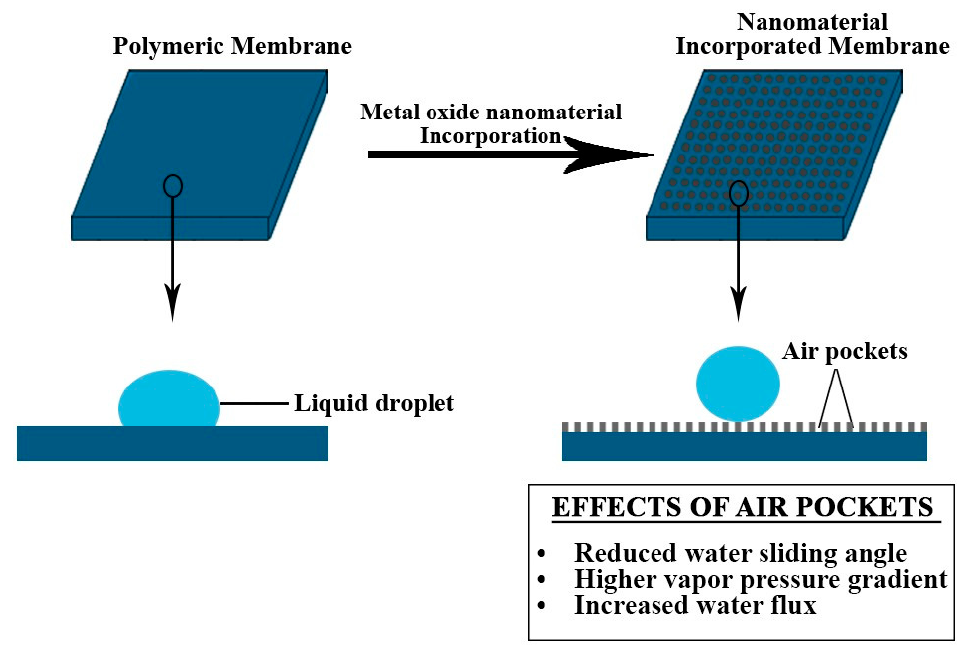
Figure 8. Illustration of air layer formation due to enhanced surface roughness.